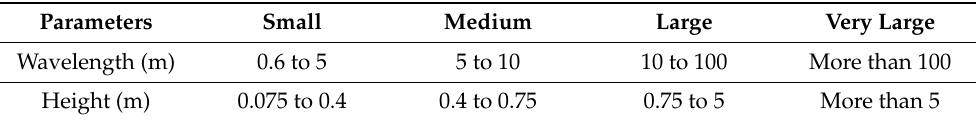
Table 1. Dune classification, adapted from